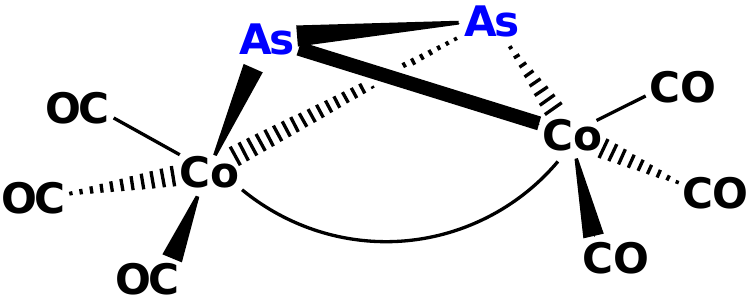
Figure 4. Schematic view of the structure of complex 6 [29].